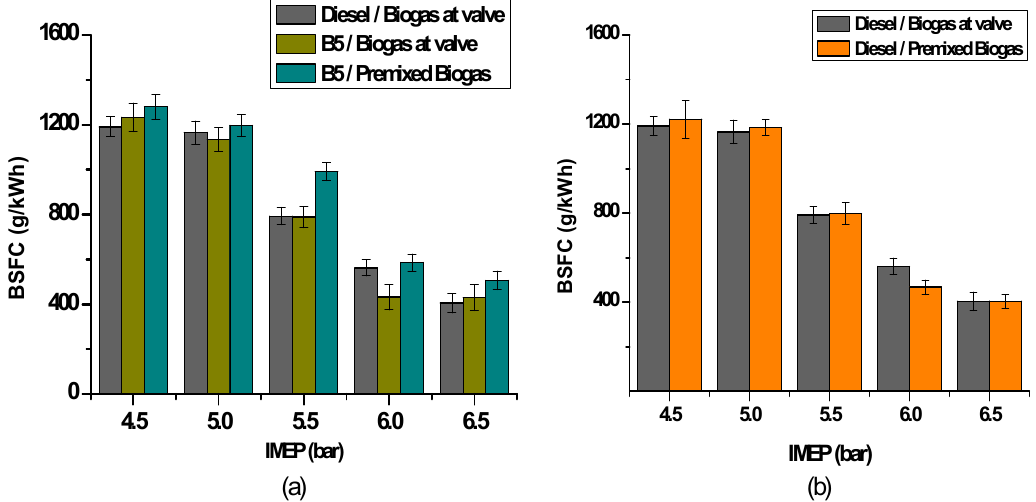
Figure 14. Variation of brake specific fuel consumption (BSFC) for ( a ) B5 / biogas RCCI in premixed and port injection at the valve and ( b ) diesel / biogas in a premixed and port injection at the valve.